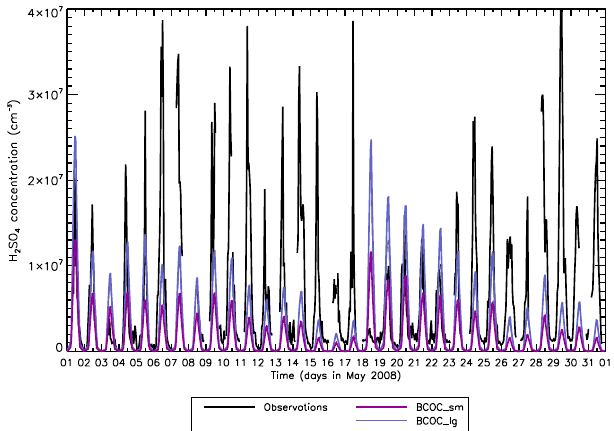
Fig. 13. Time-series of simulated (colour) and measured (black) concentrations of gas-phase sulphuric acid at the Melpitz ground site for May 2008. Model experiments, BCOC lg and BCOC sm, are described in Table